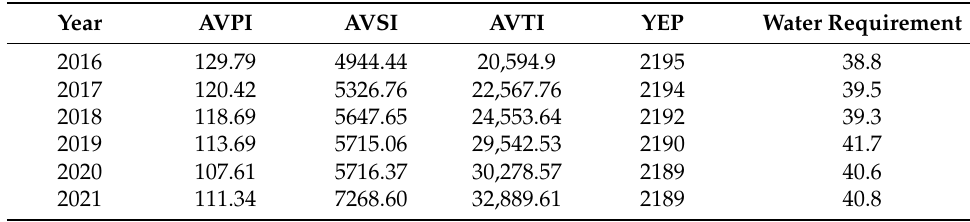
Table 2. The related data in